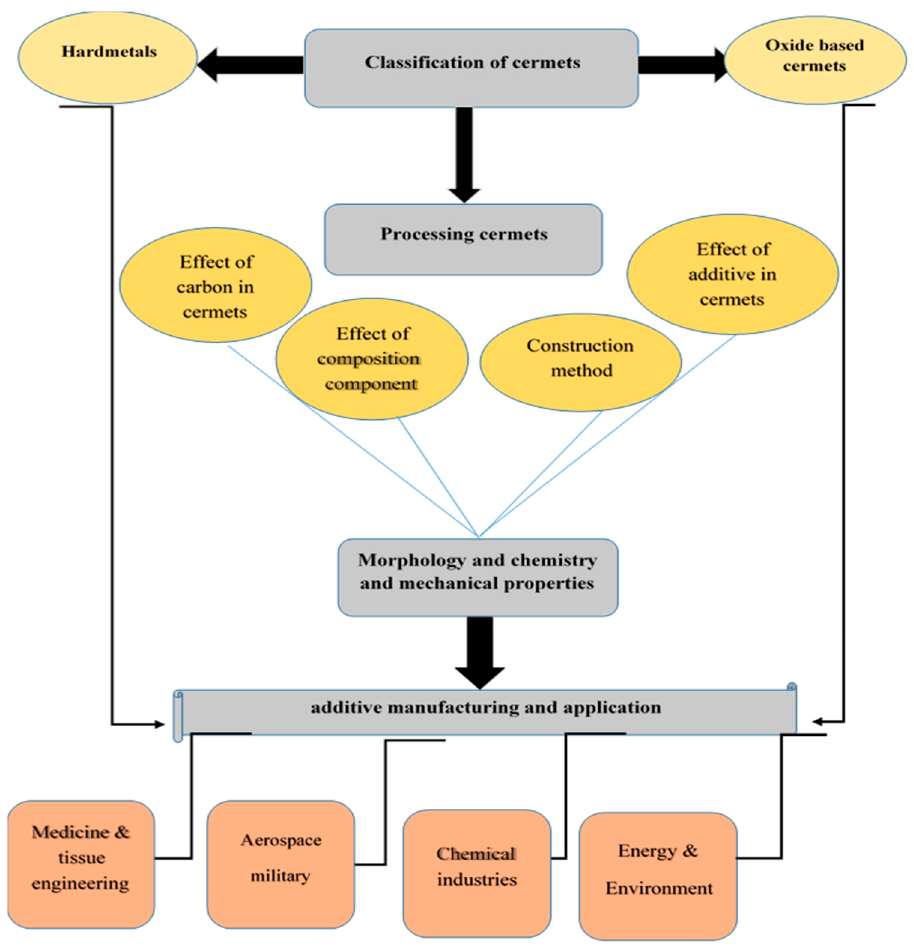
Scheme 1. Flow diagram of aspects evaluated in the article